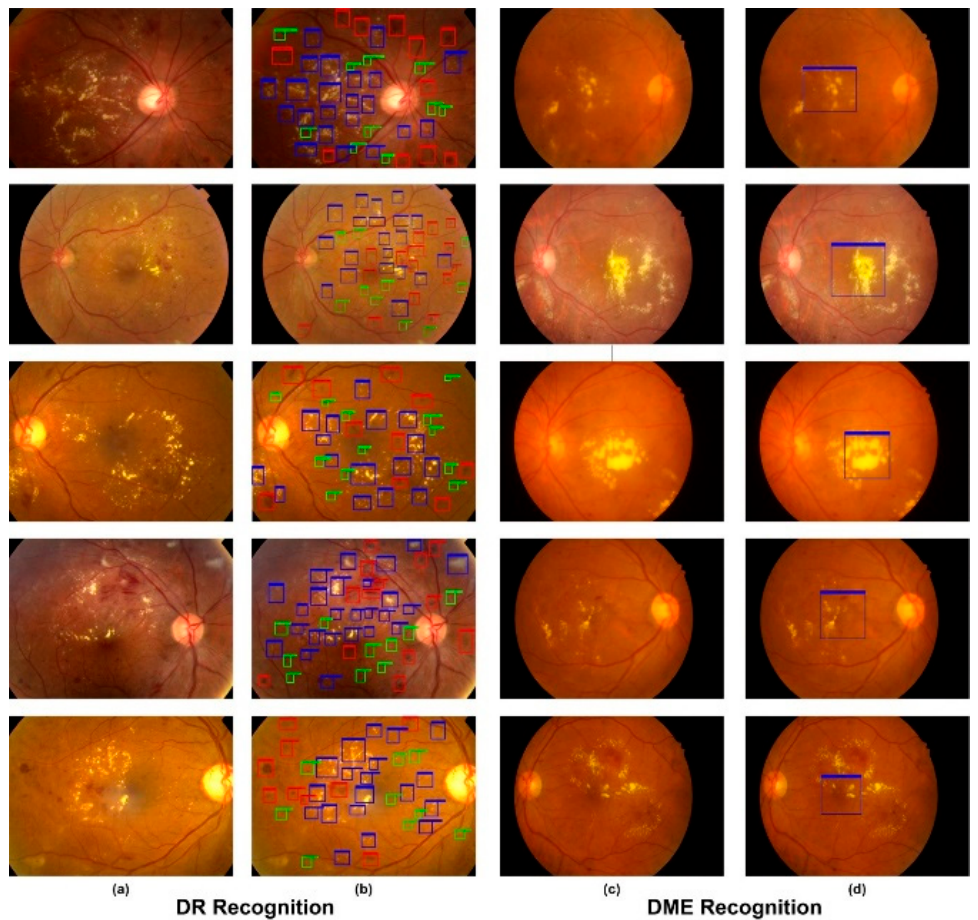
Figure 5. Test results of the proposed method. ( a ) Input images. ( b ) Localization results of DR regions; blue color shows hard exudates, green color shows microaneurysms and red color shows hemorrhages. ( c ) Input images of the IDRiD dataset. ( d ) Localization results of DME, which shows the macula region.